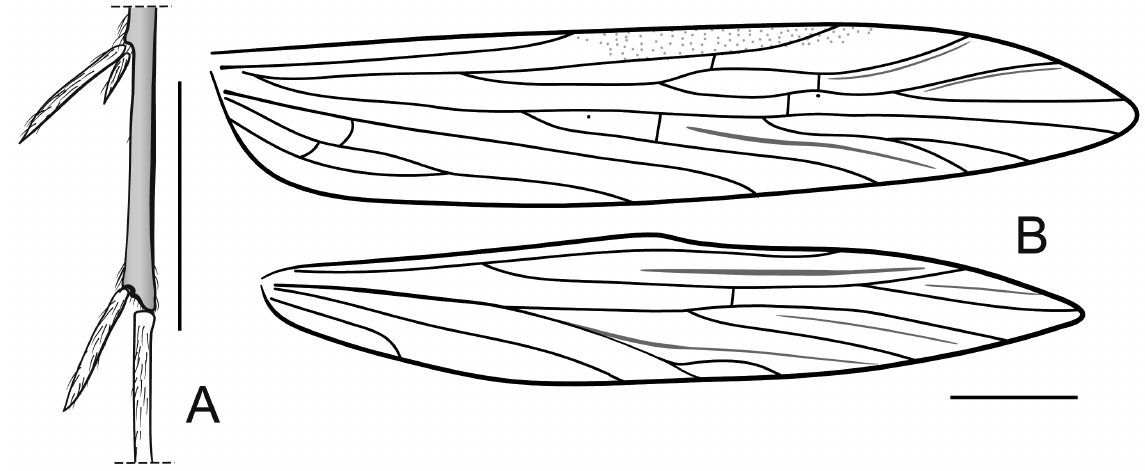
Fig. 8. Xiphocentron ( Antillotrichia ) tijuca sp. nov., holotype, adult, ♂. A . Tibial spurs of the hind leg. B . Right wings, dorsal view. Scale bars = 0.5